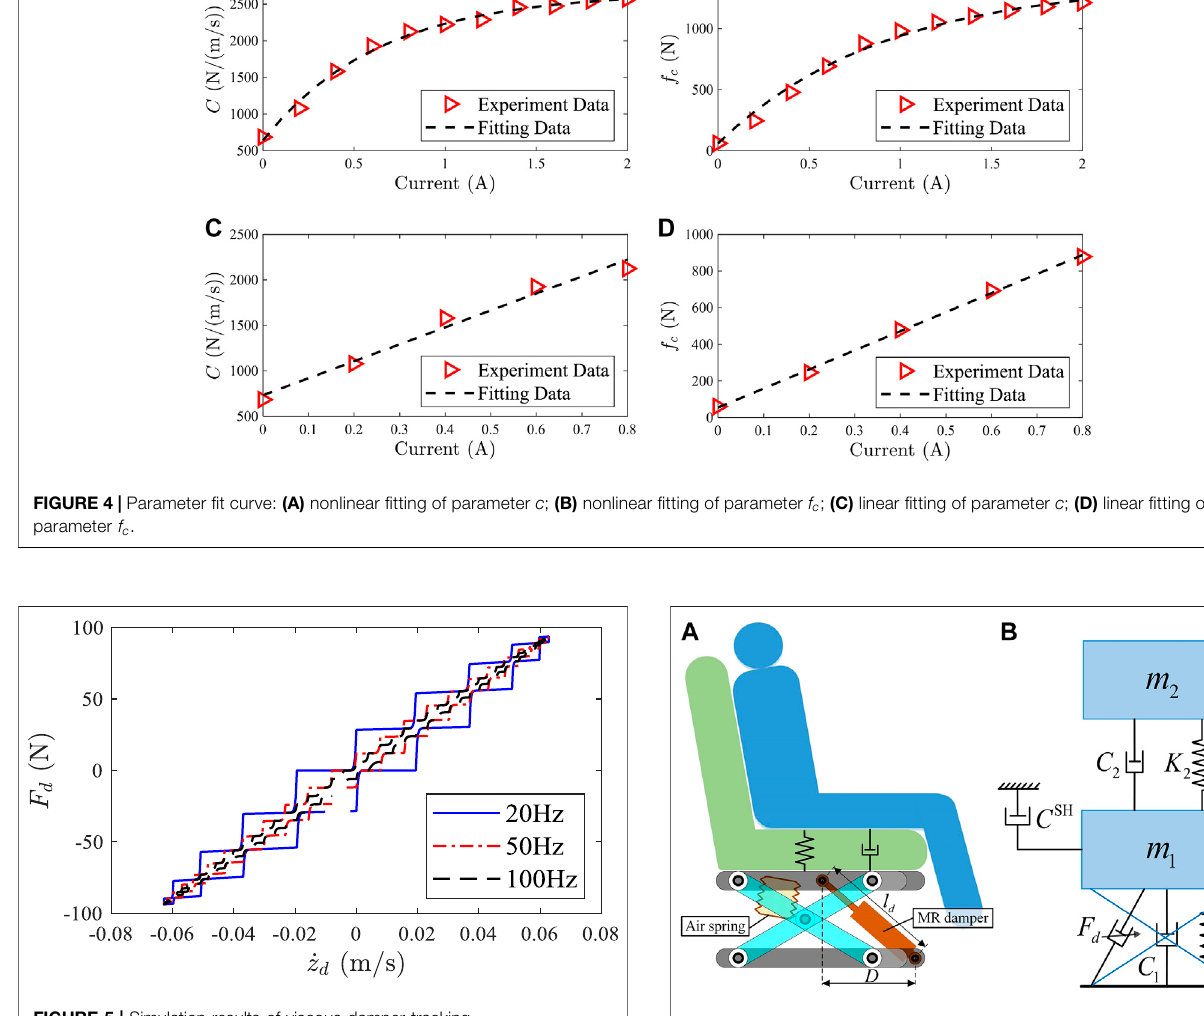
FIGURE 5 | Simulation results of viscous damper tracking.